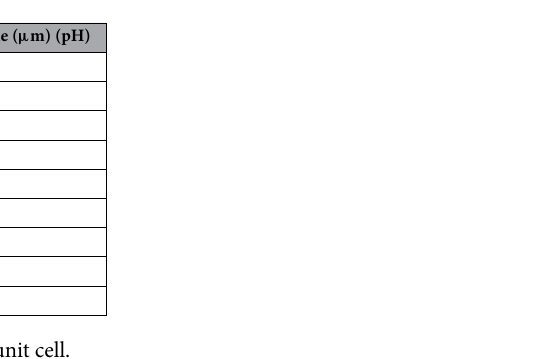
electric field profiles of each individual resonators and also that of the combined structure are studied in Figure 2. Figure 2a describes the transmission obtained from the right CSRR. The transmission plot shows a resonance dip at 0.86 THz. The black trace in Fig. 2b depicts the transmission obtained from the mid TSRR. A resonance dip at 0.97 THz is observed. Further, the transmission plot for the left CSRR in Fig. 2c portrays a resonance dip at 1.05 THz. On combining all the three resonators, as observed from Fig. 2d,e, three resonance dips (D1, D2, D3) and two resonance peaks (P1 and P2) are obtained. It may be suggested that the first dip D1 at 0.88 THz is due to the right CSRR, the second dip D2 at 0.979 THz is due to the mid TSRR and the third dip at D3 at 1.08 THz is due to the left CSRR, as can be understood from the behaviour of individual transmission plots of the three resonators. The strong near field coupling between the three resonators result in the transparency window observed in Fig. 2d,e with transparency peaks at P1 corresponding to frequency 0.907 THz and P2 correspond- ing to frequency 1.007 THz respectively. To confirm multiband EIT due to coupling between the resonators, we discuss the electric field profiles of the individual resonators and the proposed MM configurations. Figure 2f–h provides a visual understanding of